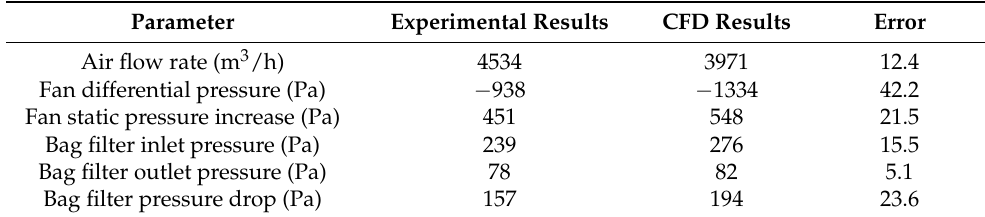
Table 5. Experimental and numerical